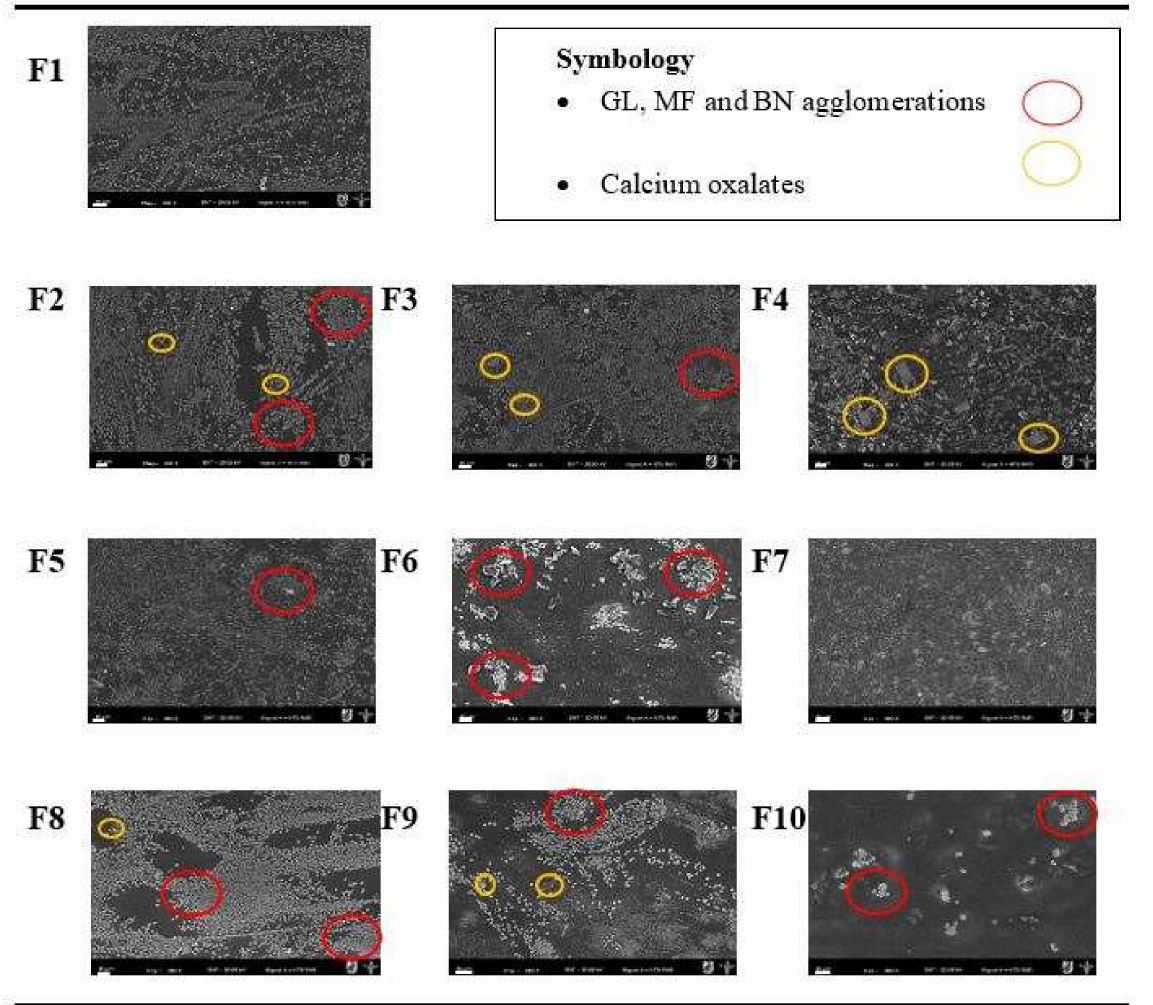
Figure 1. Superficial micrographs obtained by scanning electron microscopy (SEM) of the reinforced gelatin biofilms. The scale bar indicates 20 µ m, SEM magnification: 200 × . F1: control sample; F2–F4: samples with microfiber; F5–F7: samples with bentonite; F8–F10: samples with microfiber and bentonite. MF = Agave microfiber; BN = Bentonite; GL = Gelatin; GLY = Glycerol; DW =